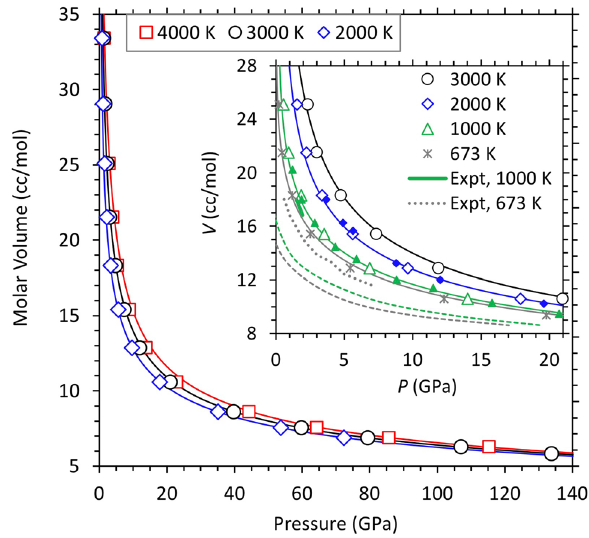
Figure 2. Volume-pressure relationships of pure liquid water at 2000, 3000, and 4000 K. Symbols represent the calculated values and curves represent the corresponding equation of state fits. The inset compares our calculated results (symbols and curves) with the available low-pressure experimental data at 673 and 973 K 34,35 and the previous calculations shown by small solid triangles and diamonds 32 . Also shown are the LDA results at 673 and 1000 K (green and gray dashed lines) which are shifted downward with respect to both the GGA and experimental results. The errors in the calculated pressure are within the size of the symbols.